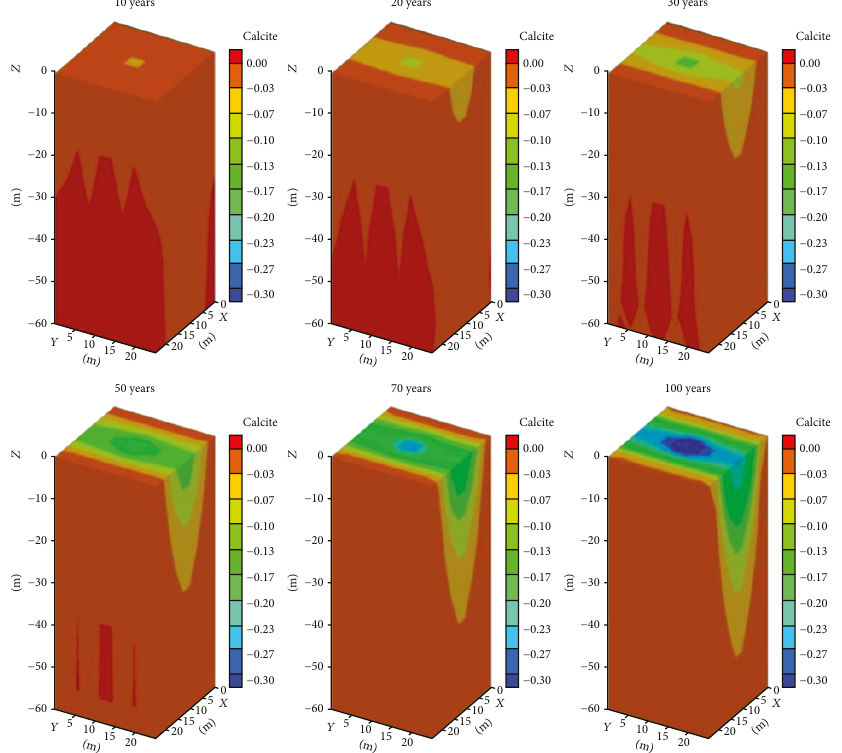
Figure 8: The corrosion range of the fi ssure under medium hydrodynamic conditions-medium permeability — 20 °